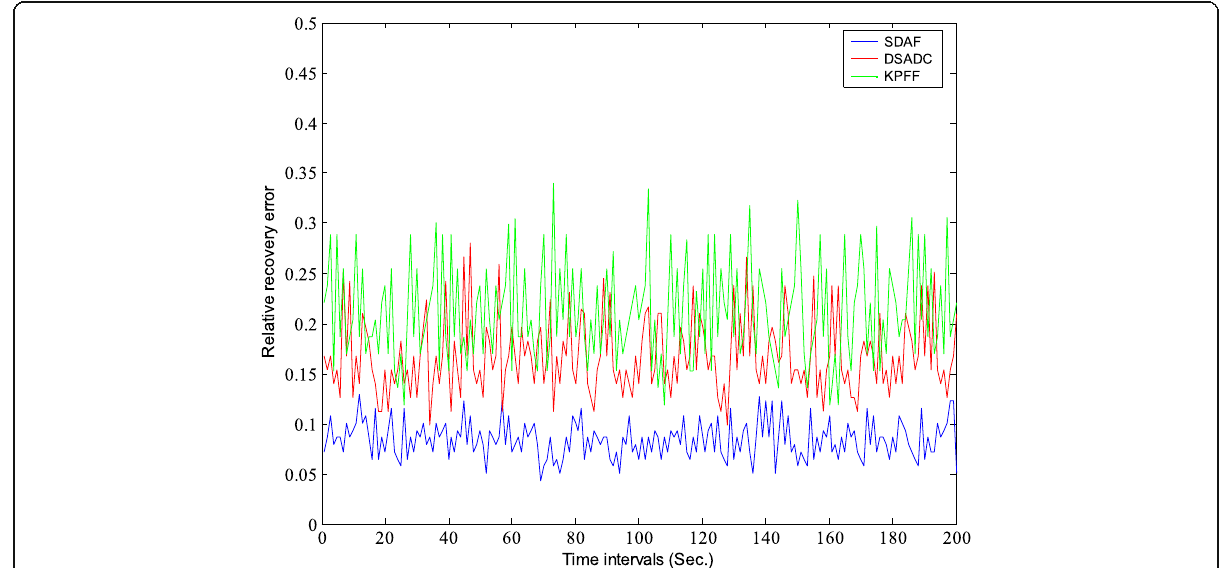
Fig. 6 RRE with outlier probability (15%). The results demonstrate adaptability with different outlier